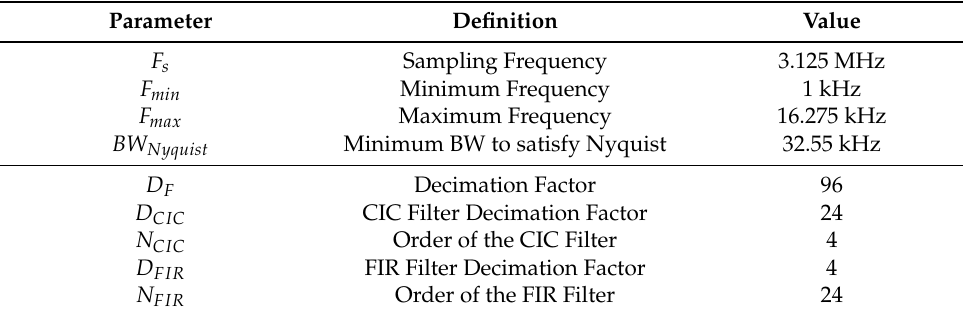
Table 3. Configuration of the reconfigurable architecture under